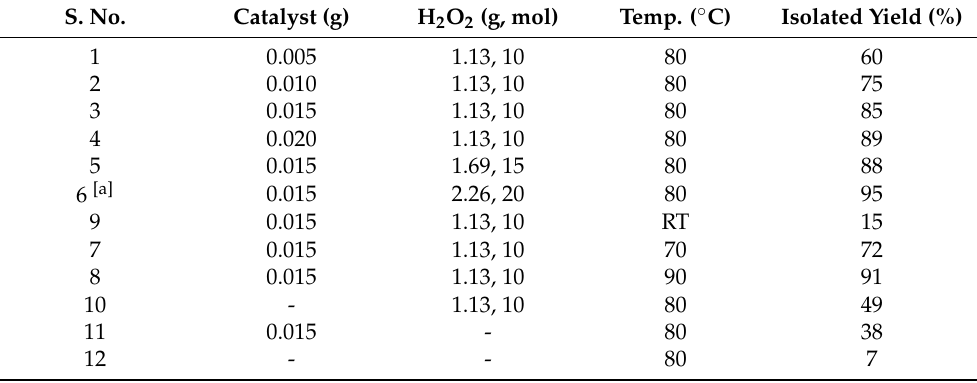
Table 2. Details for multicomponent Biginelli reaction [multicomponent reagents: benzaldehyde (0.530 g, 5 mmol), ethyl acetoacetate (0.650 g, 5 mmol), and urea (0.36 g, 6 mmol)] to optimize the reaction condition for catalyst 2 under solvent-free conditions. Results were noted after 3 h of